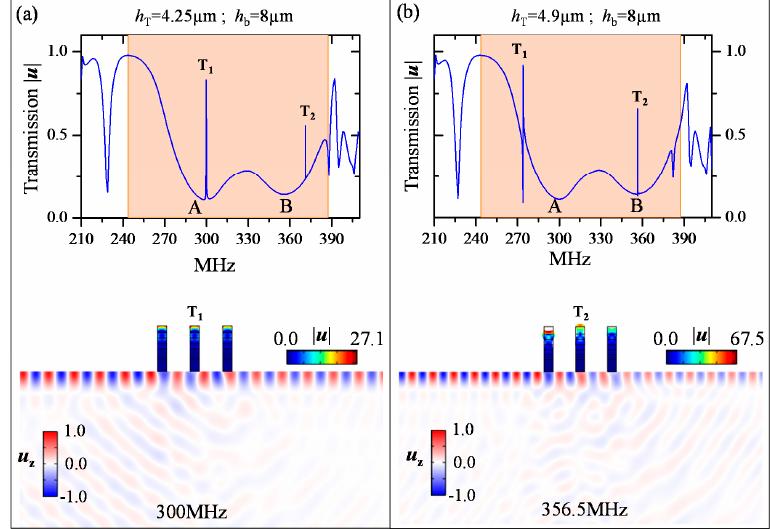
Figure 10. Transmission results: normalized total displacement’s amplitude for h T = 4.25 µm ( a ) and h T = 4.9 µm ( b ). The bottom Si layer thickness is fixed to h b = 8 µm. (Bottom panels) Total displacement field in the ridge as well as the u z component in the Si substrate for SAW at T 1 for the case h T = 4.25 µm ( a ) and T 2 for the case h T = 4.9 µm ( b ).